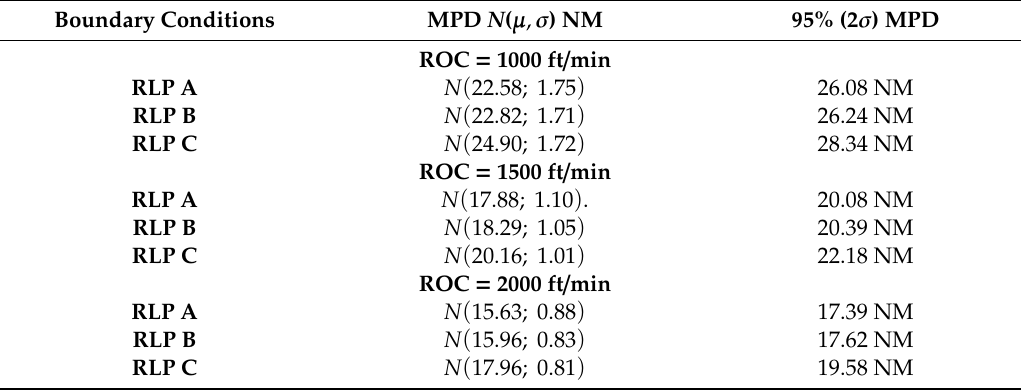
Table 5. Statistical values of MPD estimated using the Monte Carlo